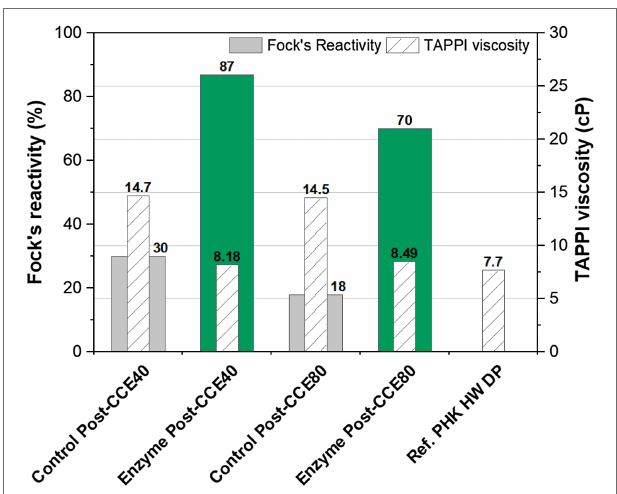
FIGURE 3 | Fock’s reactivity and viscosity of eucalyptus kraft pulp after the treatment O-X 0 -D 0 -HCE-X 1 -HCE-D 1 -CCE with enzymes (green) and without enzymes (control, grey). NaOH concentration in the post-treatment CCE was 40 or 80 g/l. X 0 : GH11 xylanase and cellulase; X 1 : only GH11 xylanase. A commercial PHK hardwood (HW) dissolving pulp is used as reference.